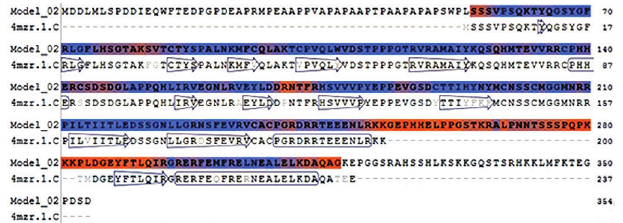
figurE 7 − TP53 gene – model – template alignment